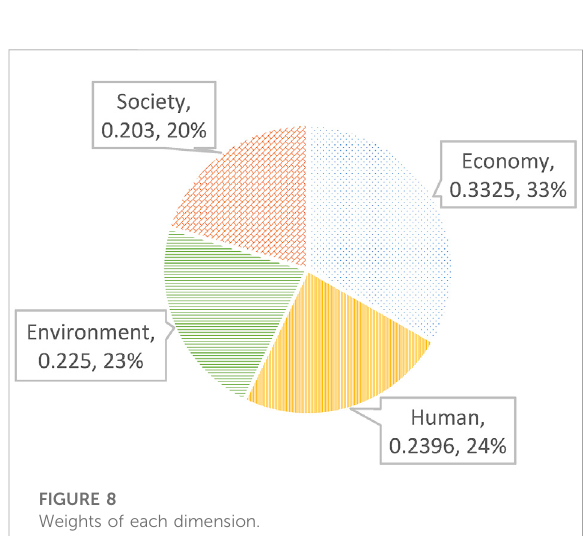
FIGURE 8 Weights of each